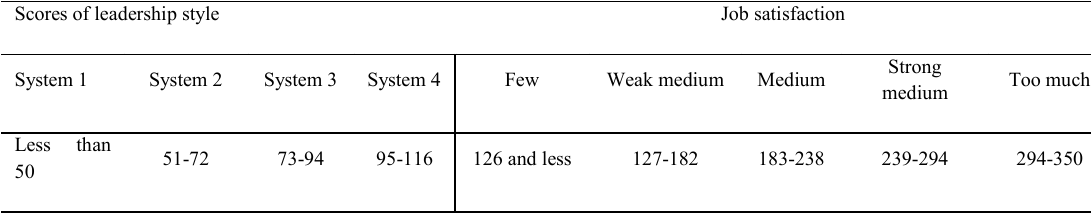
Table 1: Classification of the variables of the study scores